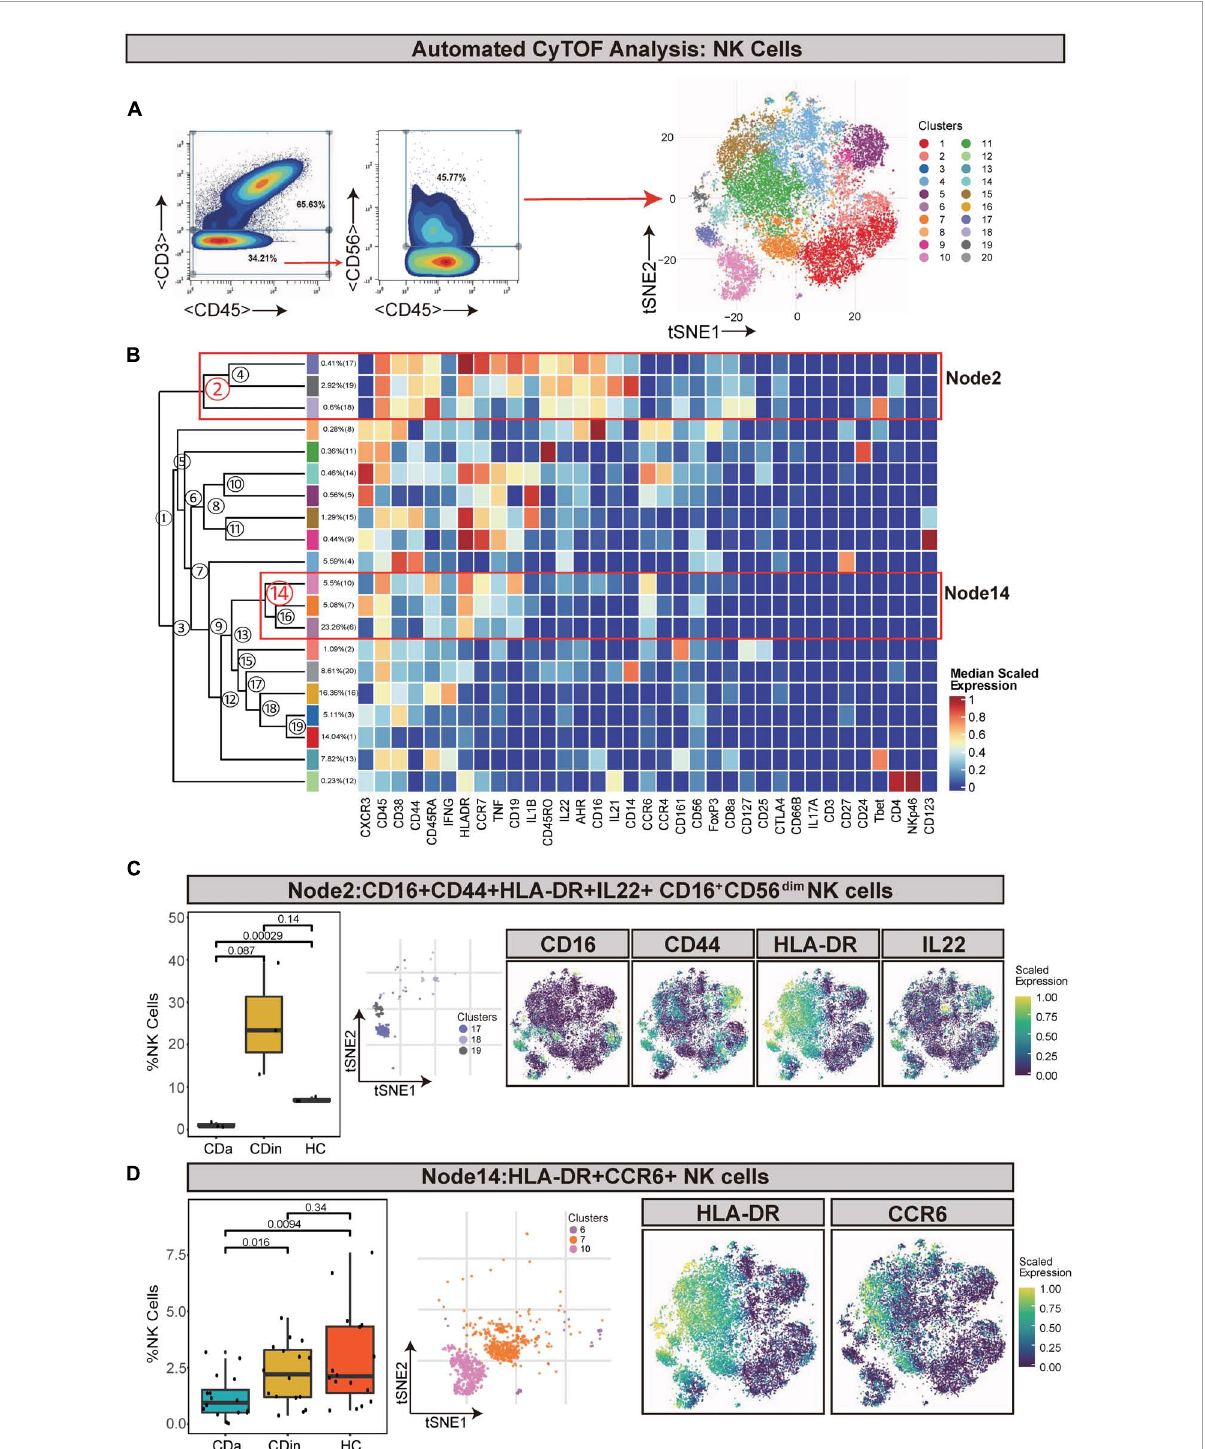
FIGURE6 CyTOF analysis showed differences in NK cells among CDa, CDin, and HC. (A) Gating strategy (left) and t-SNE projection (right) of NK cells derived from CyTOF data. (B) Cluster dendrogram and heatmap of NK cells. (C) The percentage of Node2 in NK cells among three groups (left) and the t-SNE plot of Node2 with gene expression feature plot for CD16/CD44/HLA-DR/IL22 (right). (D) The percentage of Node14 in NK cells among three groups (left) and the t-SNE plot of Node14 with gene expression feature plot for HLA-DR/CCR6